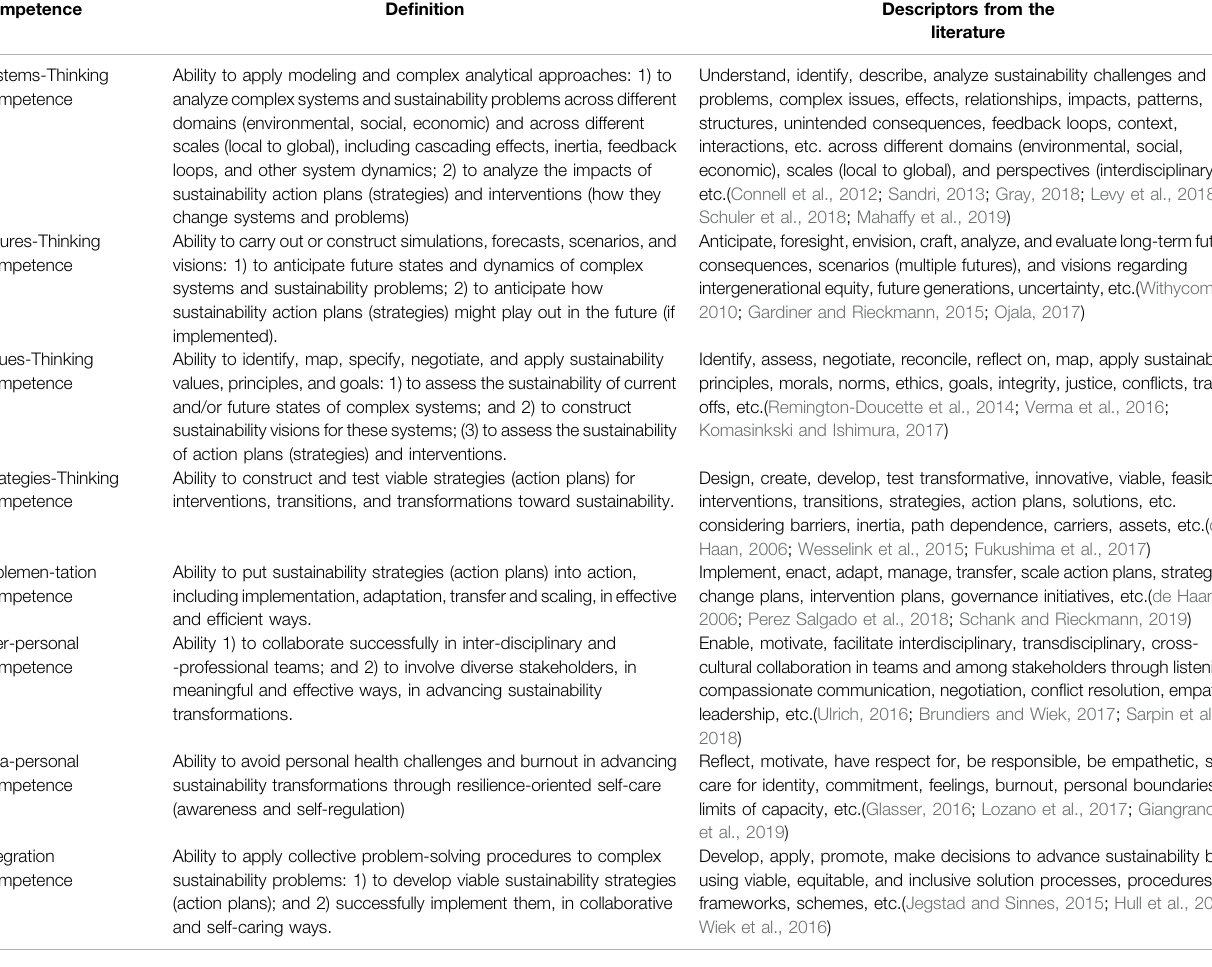
TABLE 1 | De fi nition and most common descriptors from the literature for each key competence in sustainability. Competence